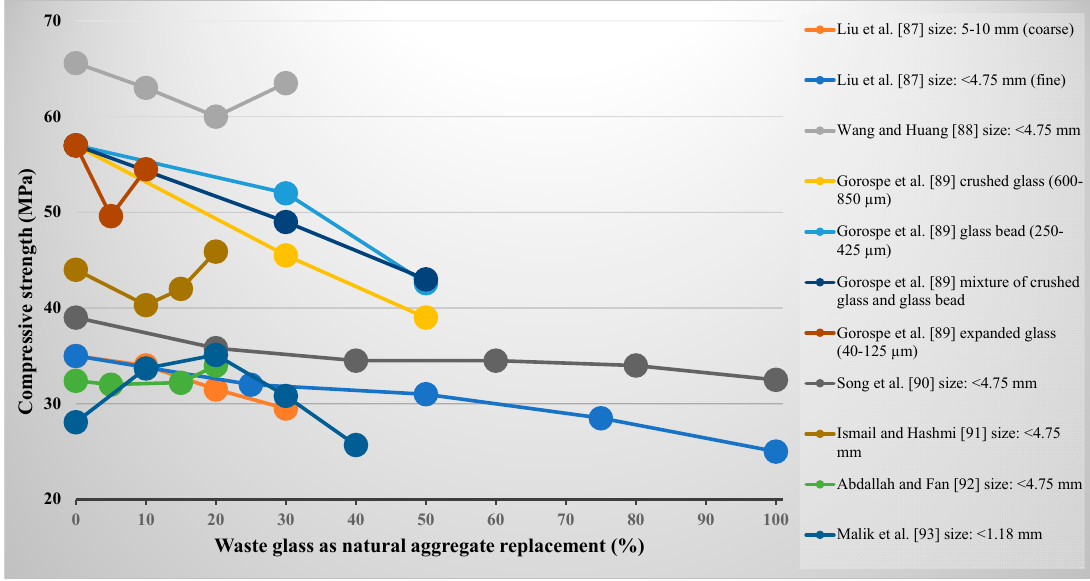
Figure 10. Effect of waste glass as a natural aggregate replacement on 28-days compressive strength.